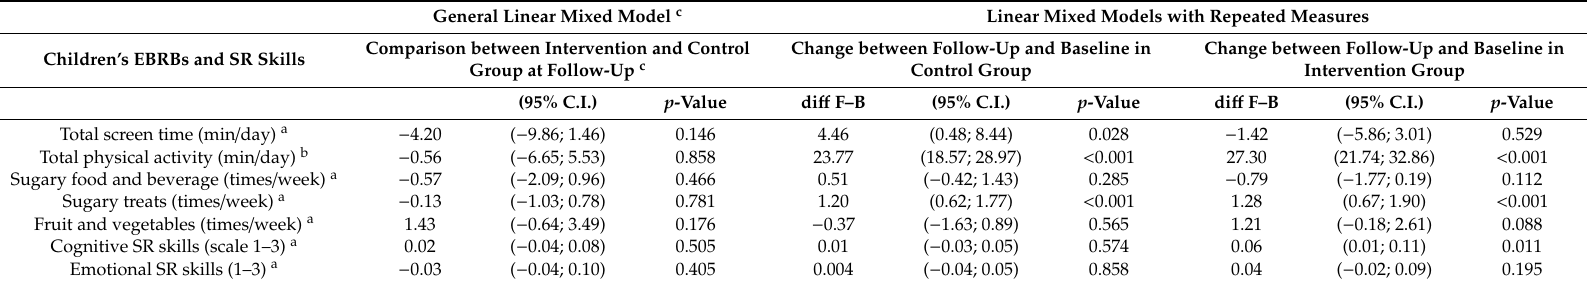
Table 3. Comparison of EBRBs and SR skills between intervention and control, and changes within the groups *. General Linear Mixed Model c Linear Mixed Models with Repeated Measures Comparison between Intervention and Control Change between Follow-Up and Baseline in Children’s EBRBs and SR Skills Group at Follow-Up c Control